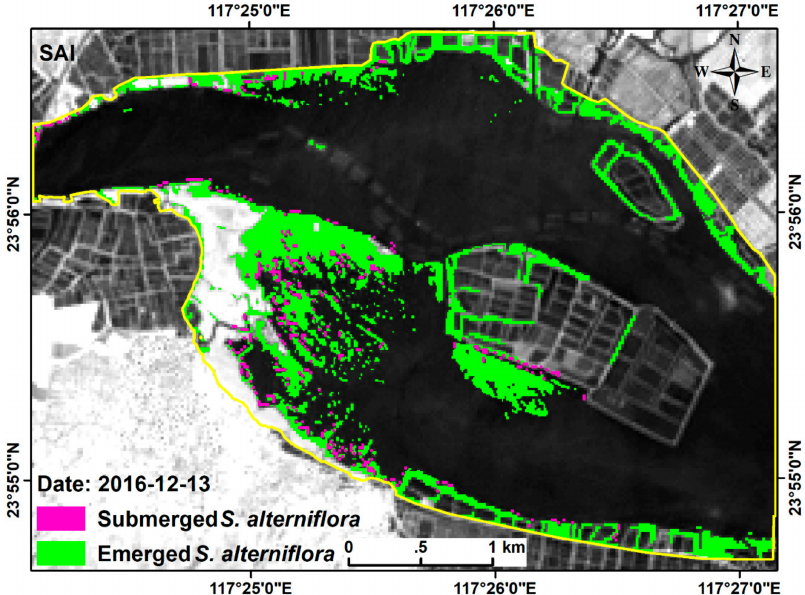
Figure 5. The distribution of S. alterniflora at high tide, including predicted S. alterniflora derived from SAI ( S. alterniflora ) and the exposed S. alterniflora (E S. alterniflora ).